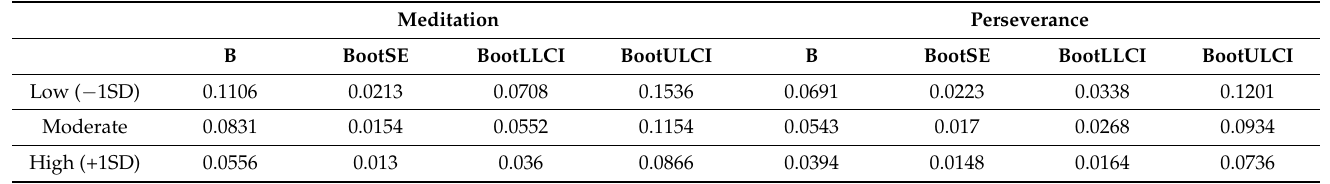
Table 4. Summary of analysis of conditional indirect effect of NFC on depression. Meditation